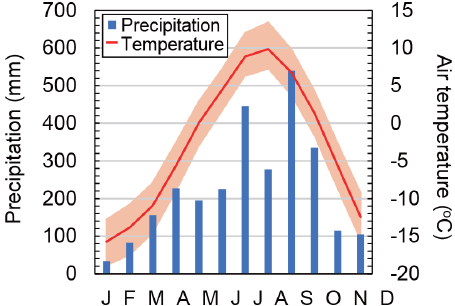
Figure 2. Average monthly precipitation at 2330ma . s . l . (RG in Fig. 1d) and air temperature around the debris flow initiation zone (3200ma . s . l . ) in the Osawa failure from 2010 to 2019. Air tem- perature around the debris flow initiation zone was estimated from data recorded at the summit station (3775ma . s . l . ) and the lapse rate (0.55). The solid air temperature curve indicates monthly average temperature, while the upper and lower bounds of the shaded area indicate the average daily maximum and minimum temperatures, respectively, in each